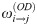
Statistical analysis of displacements in bicycle-sharing systems.We depict the probability density p(d) of the geographical distance d between initial and final stations of BSS users in the cities of (a) Chicago and (b) New York. We present statistics obtained from the analysis of the complete datasets and random transitions between the departure station i and the final location j. Simulated values are generated by using Monte Carlo simulations (MCS) with transition probabilities ωi→j(OD) calculated with information in the OD matrix and the transition probabilities ωi→j(α)(R) defined by the model in Eqs (16) and (17). Continuous lines presented with the analysis of the datasets with real registers of the mobility are used as a guide.